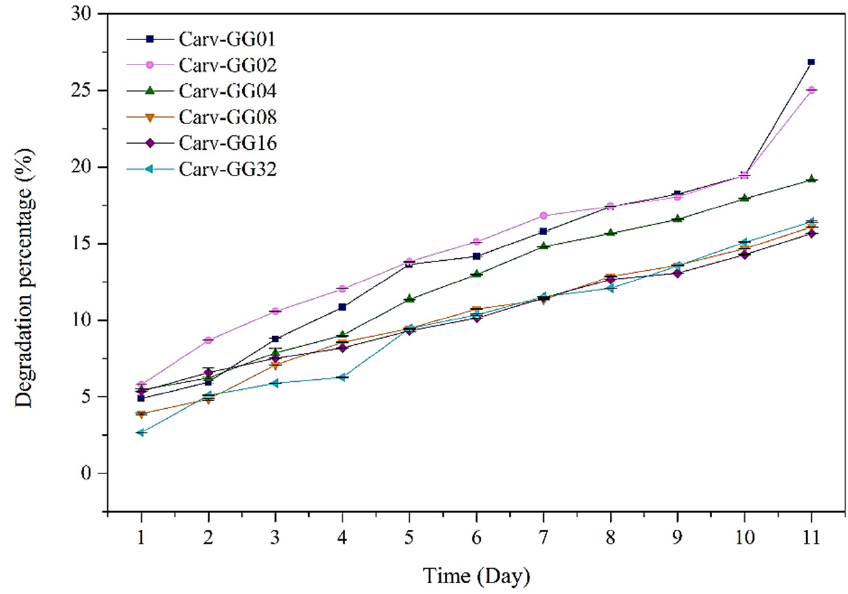
Figure 5. The time-based degradation of GG-Carv at different Carv loadings.